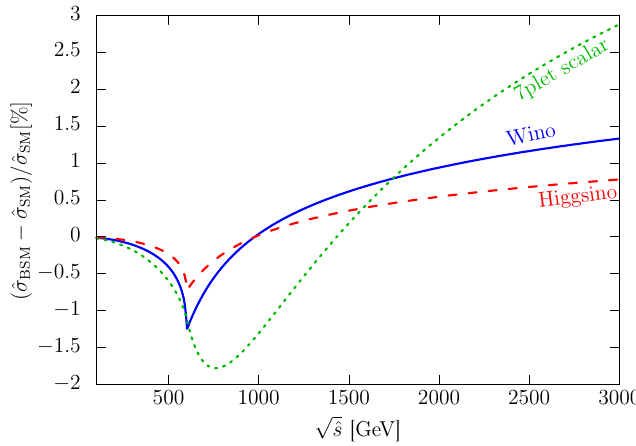
Figure 2 . The di(cid:11)erence between the di(cid:11)erential cross sections of the Drell-Yan process with and without the EWIMP contribution (normalized by the SM prediction) at the 13 TeV LHC as a function of m ‘‘ = ^ s 1 = 2 . Three EWIMP cases are depicted: Wino (Majorana fermion with the quantum number of 3 0 ), Higgsino (Dirac fermion with the quantum number of 2 minimal dark matter (real scalar with the quantum number of 7 0 ) with their masses (cid:12)xed to be 300